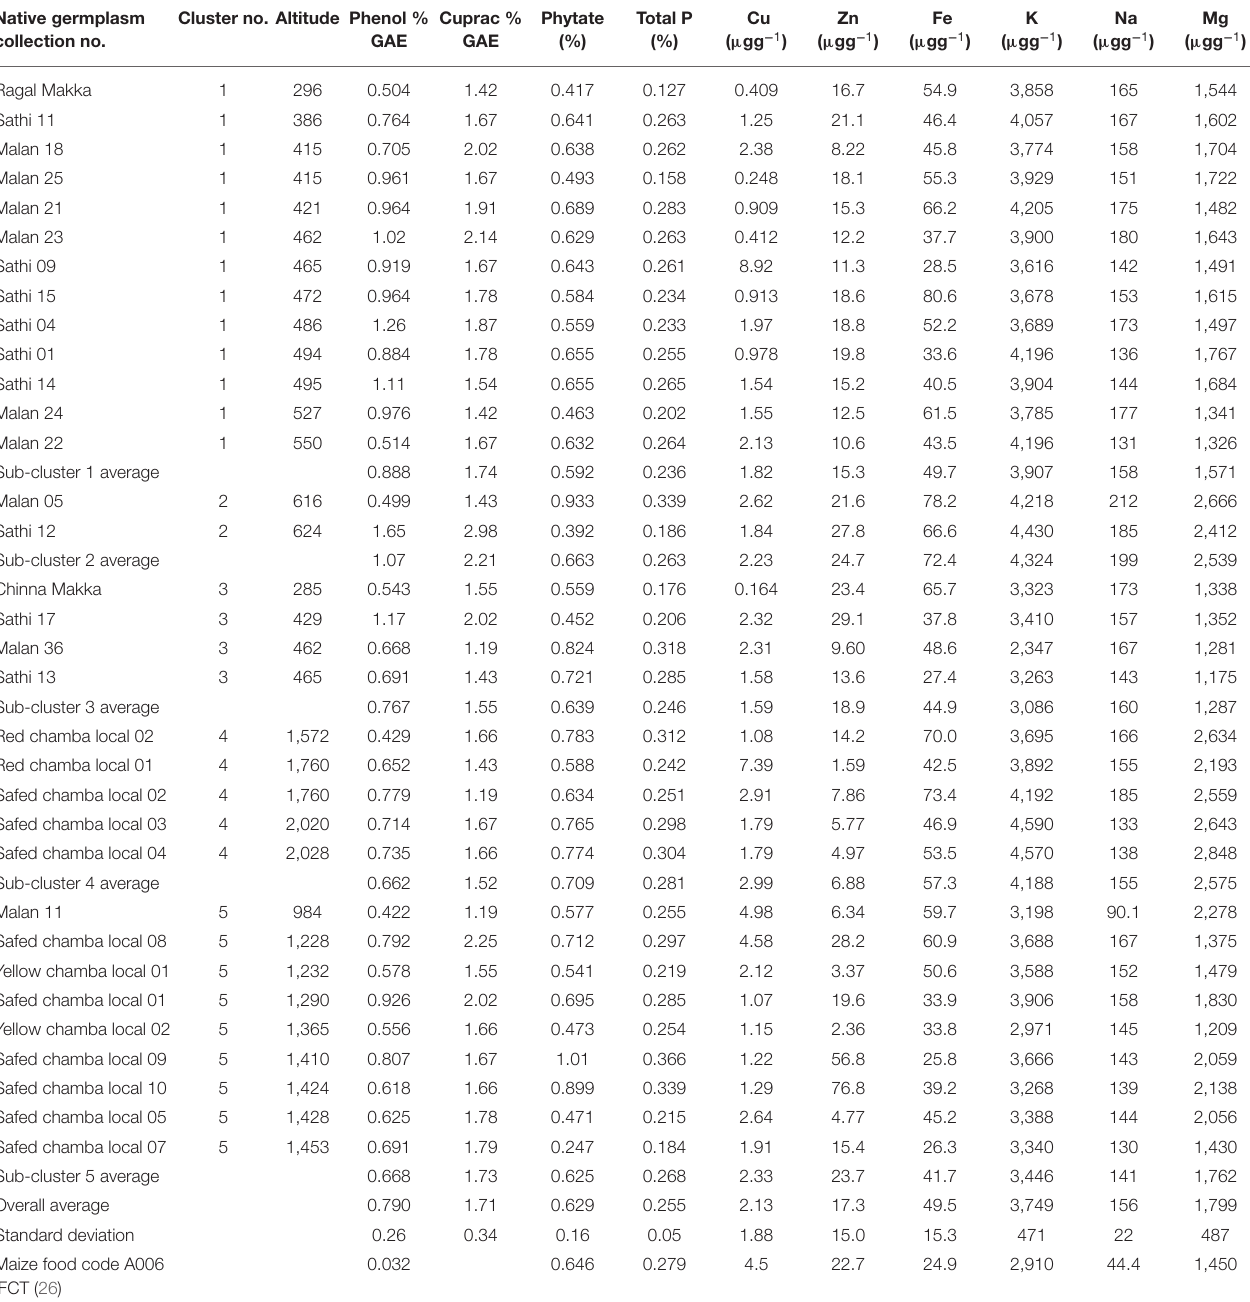
TABLE 2B | Variability in total phenols, anti-oxidant potential, phytate and minerals in maize germplasmvis-a-vis altitudinal differences. Native germplasm collection